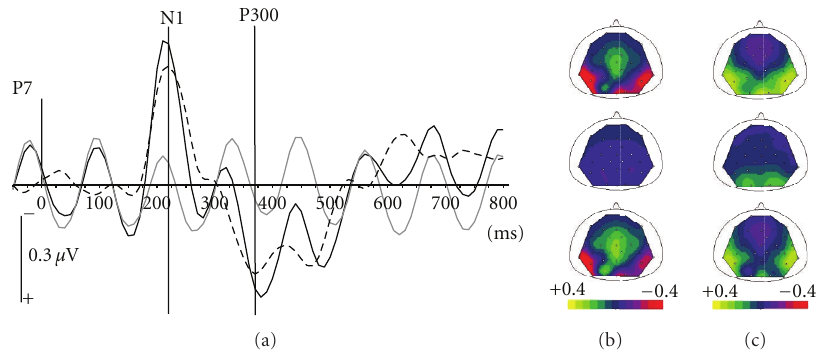
Figure 9: Grand average event-related dynamics ( − 50ms to 800 ms, channel P7) associated with responses to target flashes (black solid line), response to non-target flashes (grey solid line), and the di ff erence between the two (black dashed line) (a). Zero time corresponds to feedback onset. Topographies for correct (top), incorrect trials (middle), and their di ff erence (bottom) correspond to the latencies of the peaks of the N1 (b) and P300 (c),